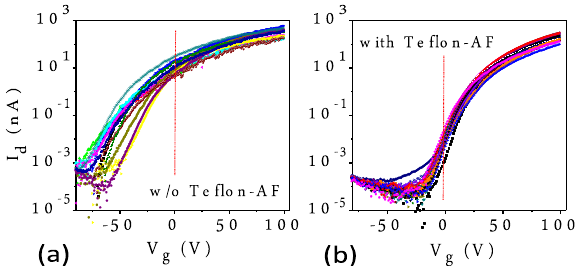
Figure 3. Transfer characteristics of representative FETs before ( a ); and after ( b ) applying Teflon ‐ AF. The y ‐ axis is I d in nA unites for both cases and the dotted lines are visual guides emphasizing the V th shift after applying the polymer cap.